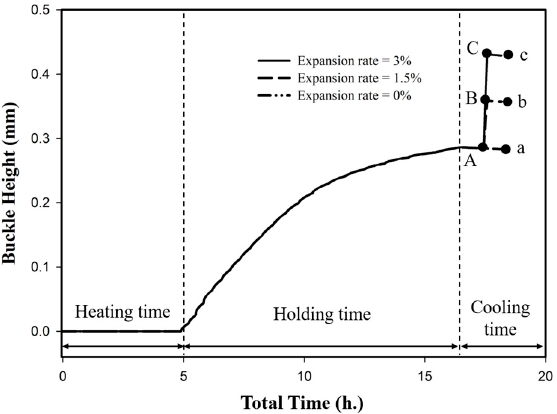
Figure 6. Buckle height of YSZ induced by CMAS infiltration during a thermal cycle with different expansion rates.